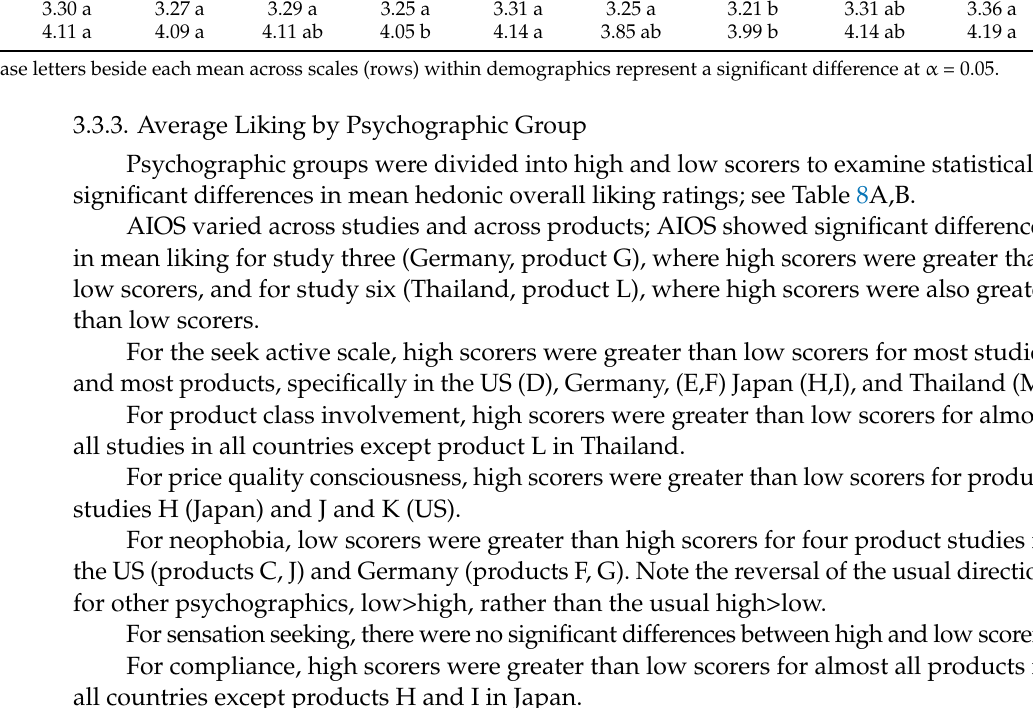
Test Lapsed Supplement